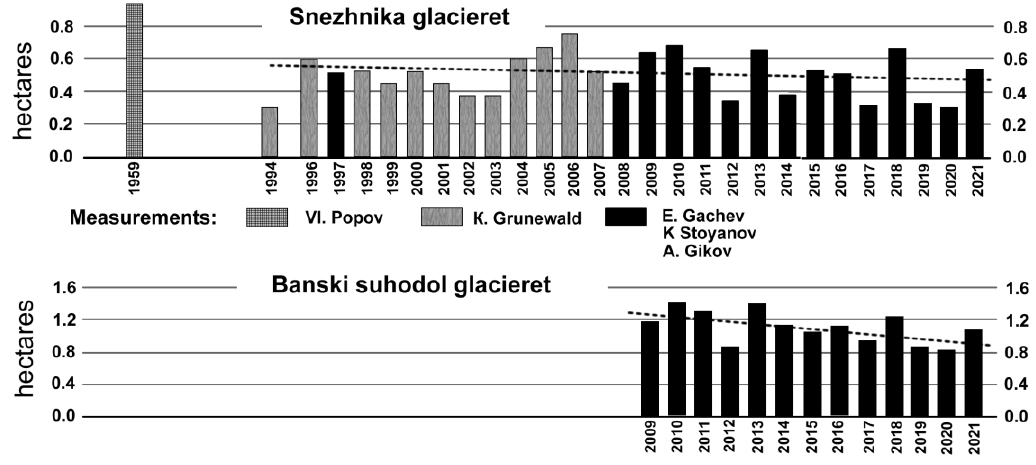
Figure 3. Surface area of the glacierets in the Pirin Mountains (real, not projected surface). Banski suhodol glacieret has a much smaller amplitude of interannual size variations than Snezhnika glacieret. For the common period of observation (2009–2021), the variation coefficient (Cv) is 0.15 for Banski suhodol glacieret, while for Snezhnika it is 0.28 (and 0.25 for the whole period of regular monitoring, 1994–2021). The observed differences can be explained by the different topographical conditions of both glacierets (Figure 4).